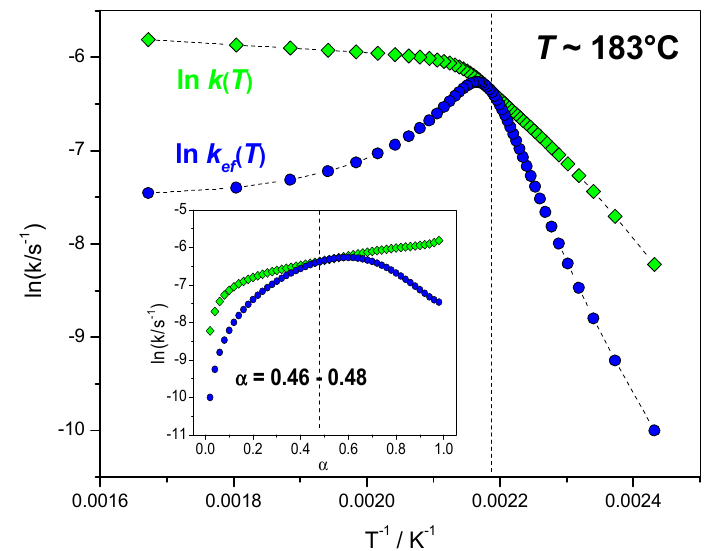
Figure 9. Green lozenges: variation of ln k ( T ) computed as ln k ( T ) = ln( A α )– E α / ( RT α ) as a function of reciprocal temperature, blue circles: variation of ln k ef ( T ) computed using Equation (10) as a function of reciprocal temperature.